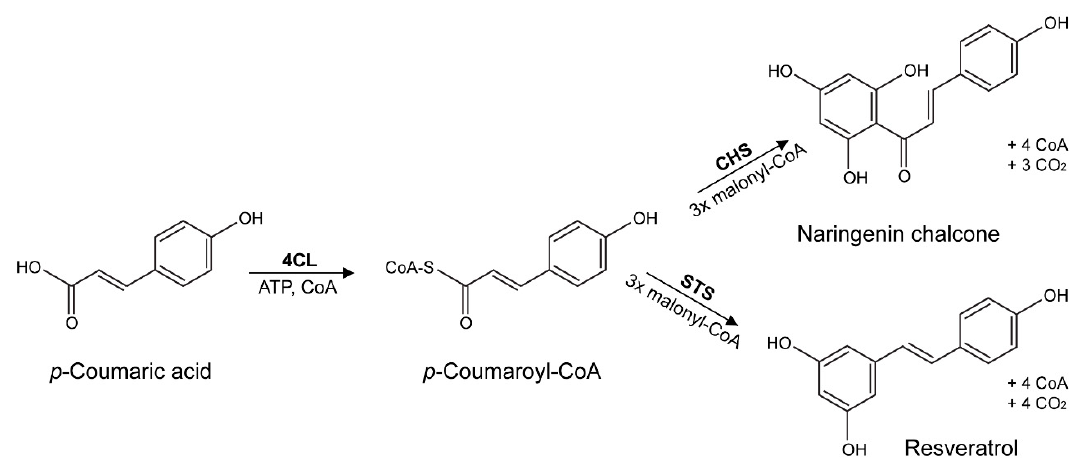
Figure 1. Enzymatic reactions catalysed by type III PKSs for the production of naringenin chalcone and resveratrol.